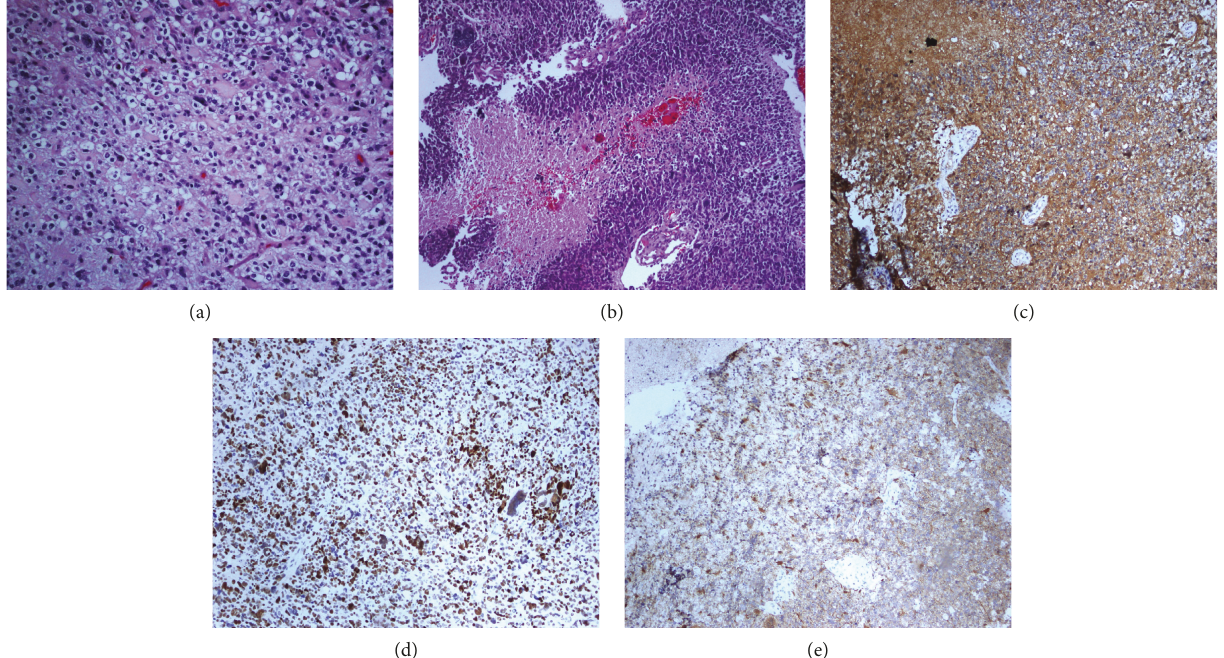
Figure 3: (a) Foci of oligodendroglial component featuring clear cytoplasm, round nuclei (200x). The neoplastic cells showed (b) necrosis (100x), (c) GFAP(+) (100x), (d) p53(+) (100x), and (e) IDH1(+)